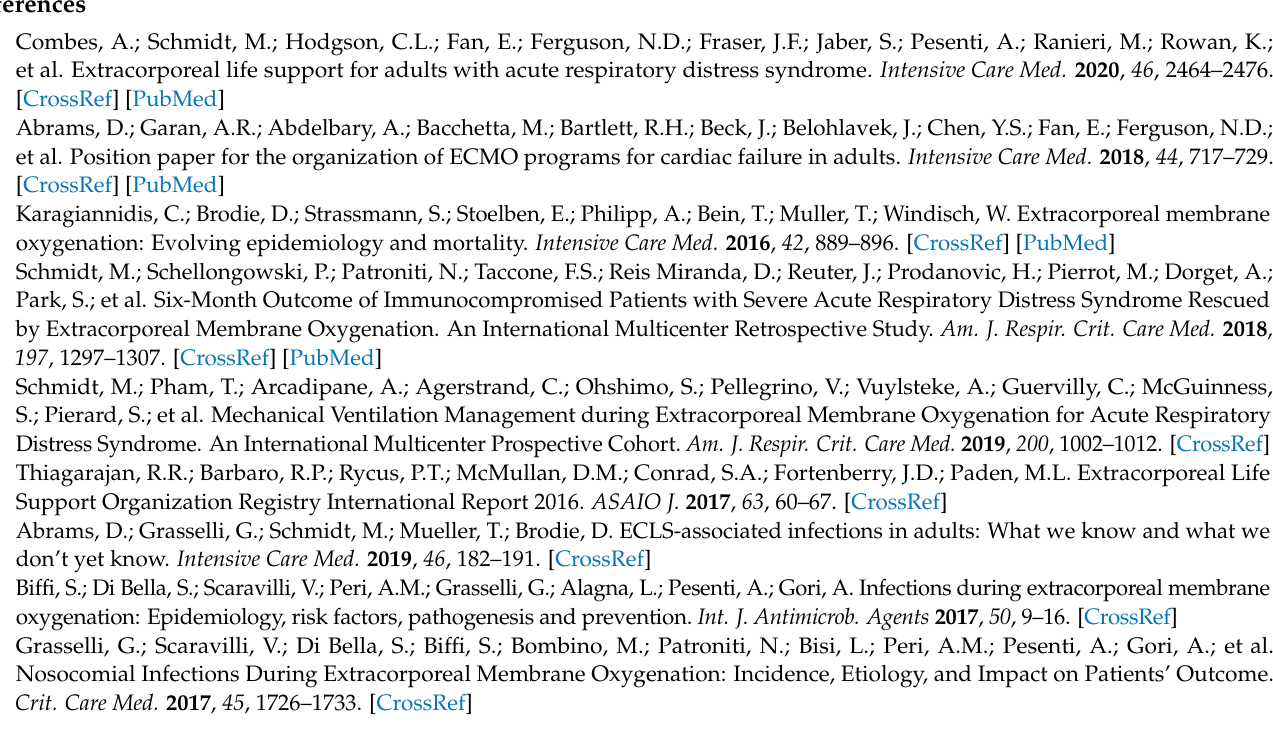
Figure S2: Goodness-of-fit plots, Figure S3: Individual pharmacokinetic